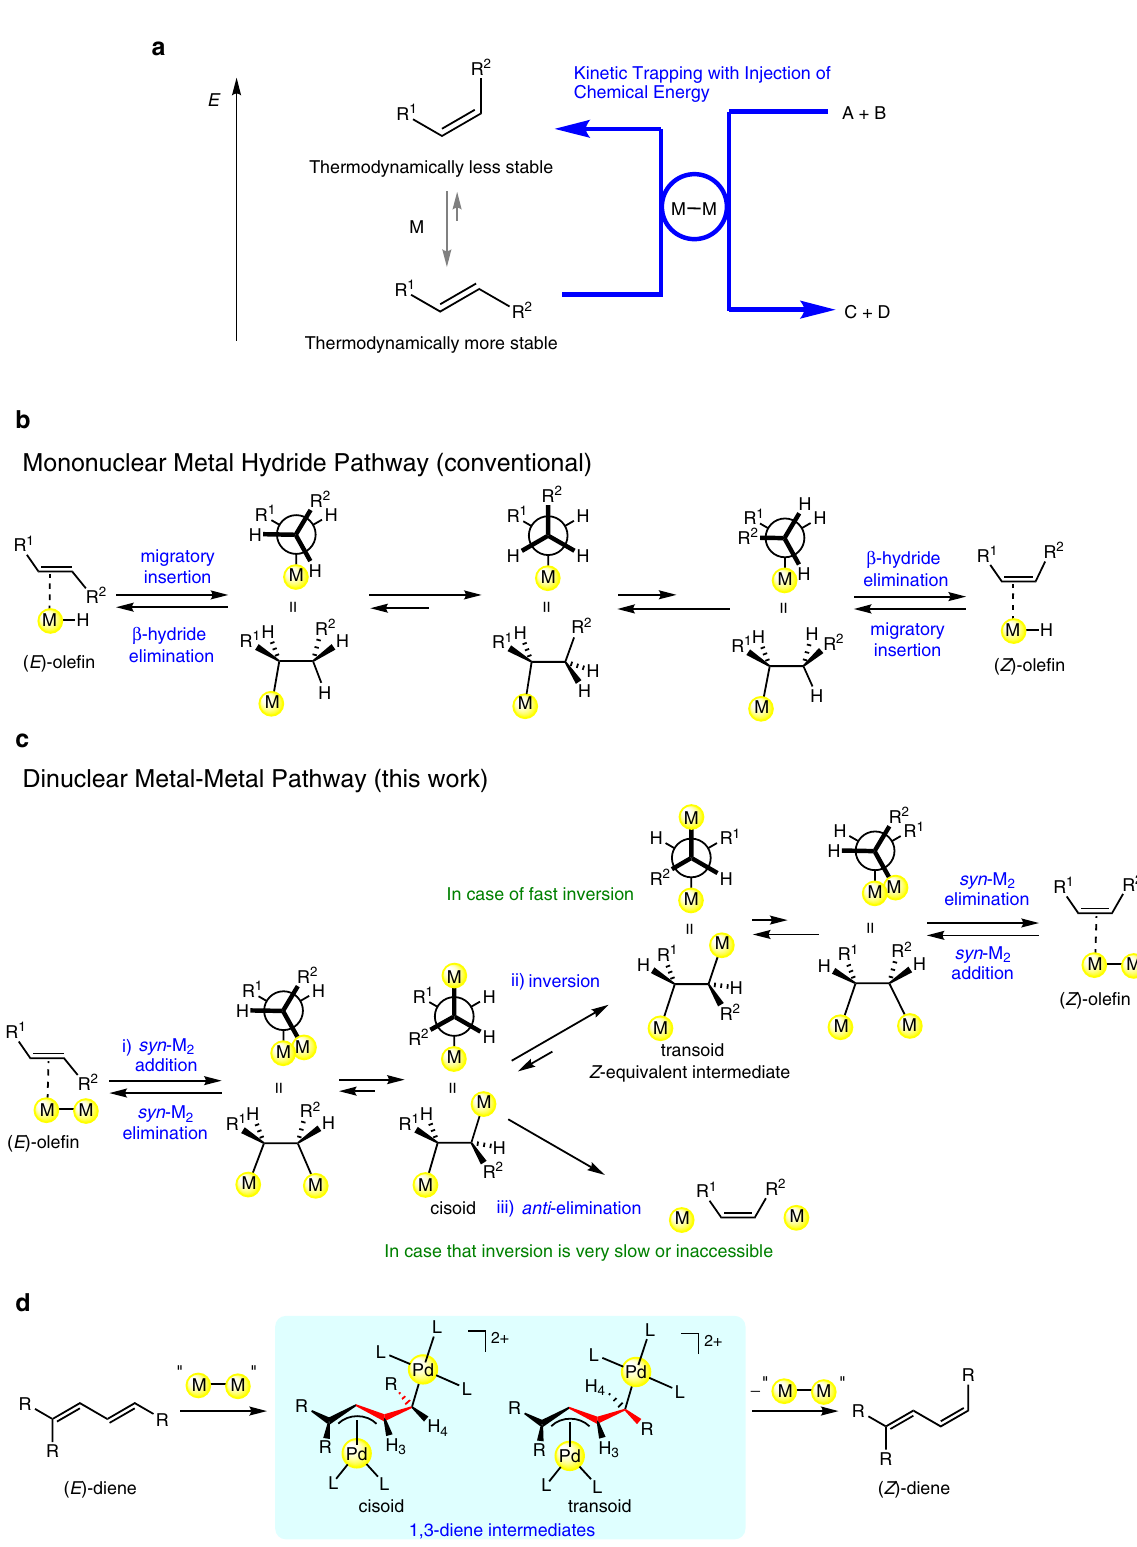
Fig. 1 Isomerization of alkenes. a A qualitative energy pro fi le of Z -alkenes and E -alkenes. An M – M complex may promote E to Z geometric isomerization of alkenes through a dinuclear mechanism. The chemical energy required for the E to Z isomerization may come from the reaction energy of a coupled reaction (A + B → C + D), where the common M – M species are shared, making the net reaction exergonic. b A simpli fi ed model for the mononuclear metal hydride pathway which is a representative and conventional mechanism for Z to E isomerization. c A dinuclear M – M pathway that enables kinetic trapping of Z -alkene. d The key intermediates for the isomerization of